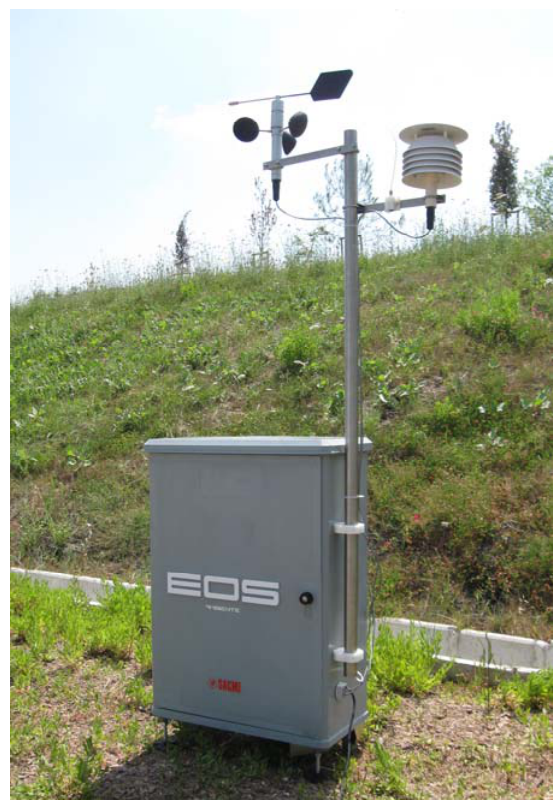
Figure 2. The EOS 507 electronic